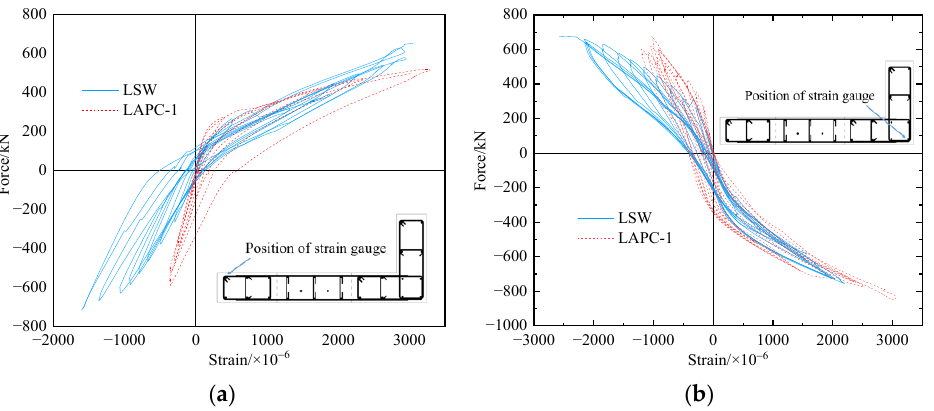
Figure 12. Force – strain curves of the rebars of specimens LSW and LAPC-1 at 10 mm above the base beam: ( a ) the outermost longitudinal rebars of the straight-edge member; and ( b ) the outermost longitudinal rebars of the L-shaped-edge member.